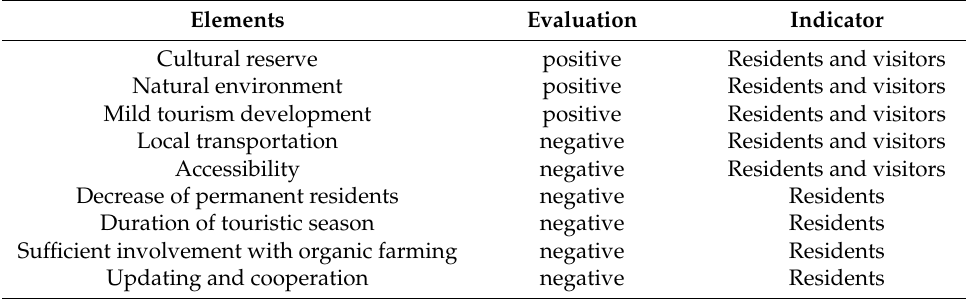
Table 2. Evaluation of Kythera’s elements according to their residents and